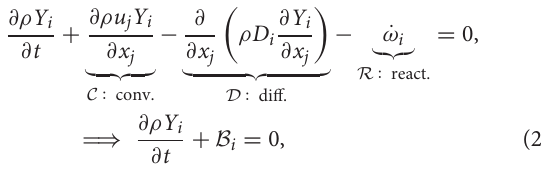
FIGURE 6 | (A) Variation of 1 Y OH with θ for sample collected in the initial 5% of the computation domain and with NP1. The line denotes h θ | 1 Y OH i , adapted from Doan and Swaminathan (2019c) with permission. (B) PDF of 1 Y OH conditioned on ˙ Q for the case NP1 at an arbitrarily chosen time, adapted from Doan and Swaminathan (2019a) under a Creative Commons